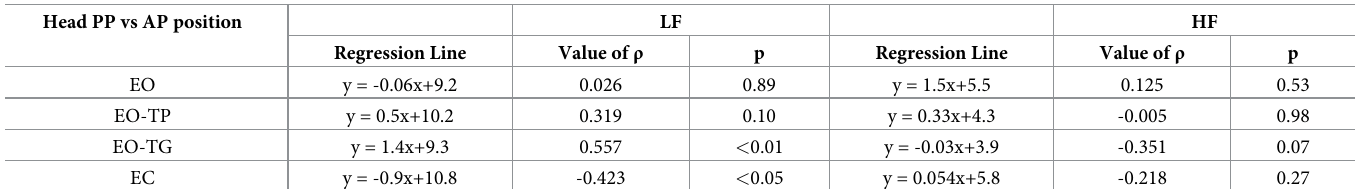
cycles. The period of adaptation that precedes steady state depends on vision and frequency conditions and is different for head and pelvis. Conversely, the body orientation in space (the mean AP position in space of head and pelvis) does not undergo any remarkable change over time. Apparently, individuals do not search for a more secure (protecting from a backward trip) but costly postural attitude (increase in postural muscle activity), such as for instance tilt- ing forward in order to move the centre of pressure closer to the midpoint of foot length [68, 69]. Likely, the orientation in space normally adopted during quiet stance represents a strong reference around which perturbation-induced oscillations are organized [70], particularly so when the two supra-postural visual task are being performed. Around the relatively unvarying mean position, the amplitude of the PP displacement var- ies over time. At low platform translation frequency (LF), the amplitude of the PP displace- ment of the head and pelvis is larger at steady state compared to the value at the beginning of the perturbation trials under the various visual conditions. The adaptation process features a gradual increase of the PP motion of the segments as a function of the successive cycles (the adaptation index has a positive value). The steady state is reached after one-two cycles with EO, while a slower time-course occurs in the other visual conditions, where the time-constant is not different among EO-TG, EO-TP and EC. Consistently, the amount of adaptation (the Adaptation Index, AI) was modest or negligible with EO for both head and pelvis, but large in the other visual conditions. Incidentally, it is appropriate here to consider that the values of the time constants computed from the exponential model, when applied to the EO data, may be affected by a bias connected with the small amplitude of the parameter B (the difference between intercept and asymptote of the fitted function). For small values of B, as occurs with EO where adaptation is quite limited, the variance of the estimated time-constant increases